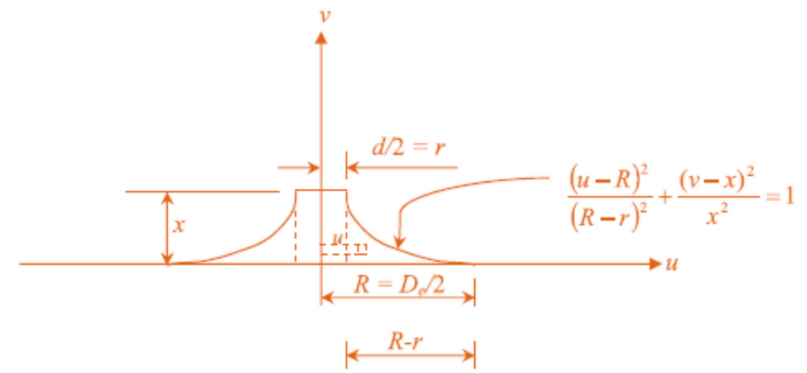
Figure 20. Idealized diagram for estimating the amount of composite mass expelled from the top